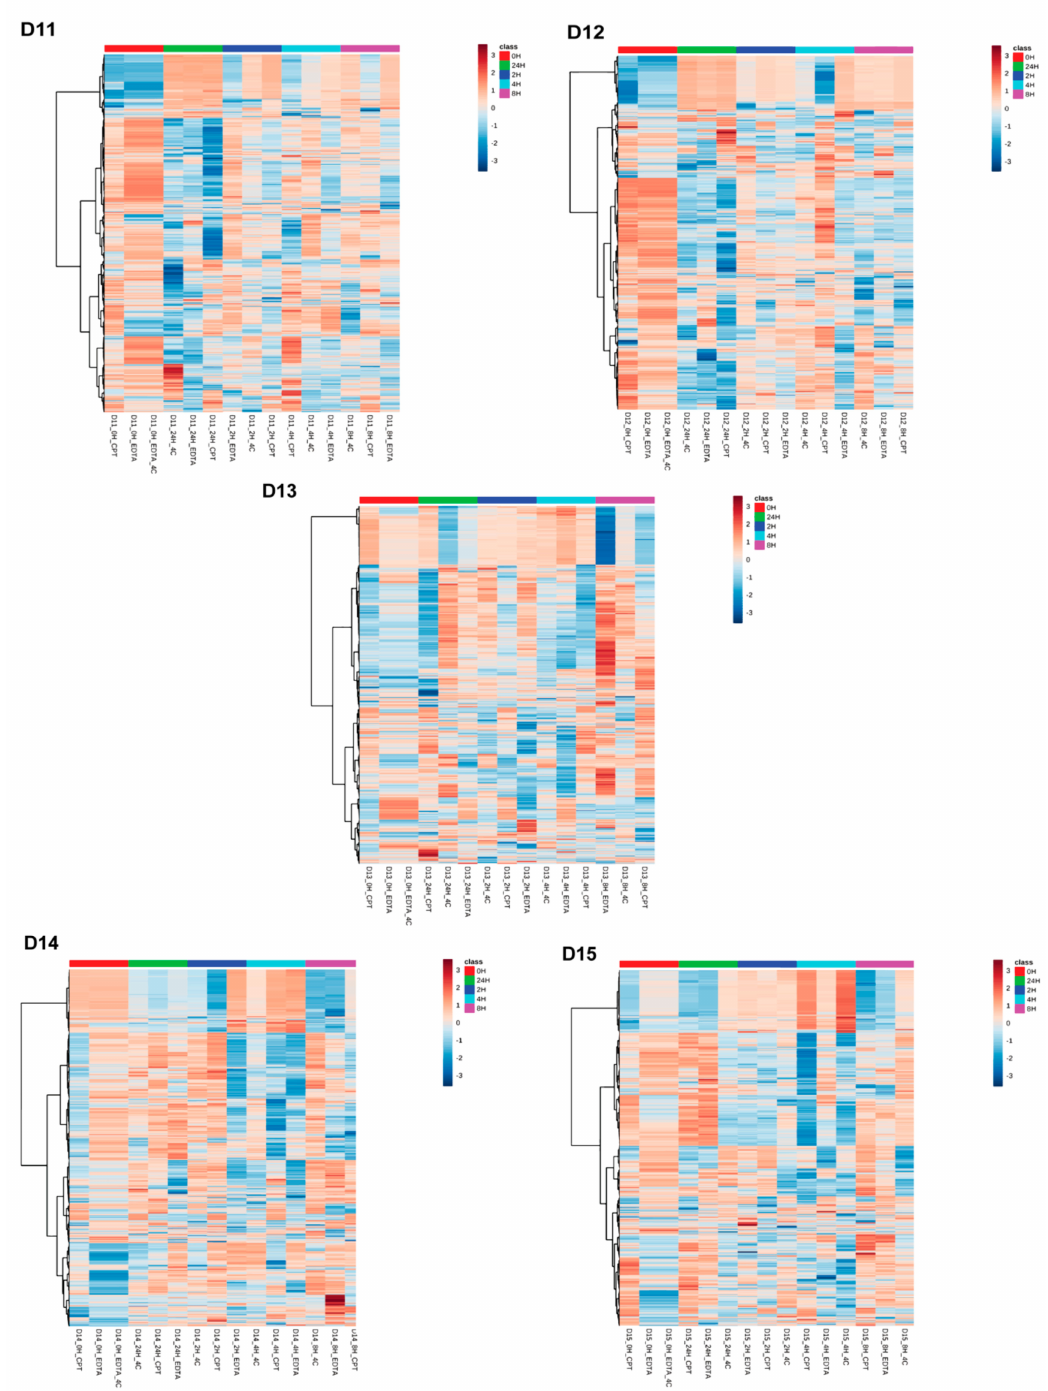
Figure 5. Two-way hierarchical clustering analysis using Euclidean distance and ward.D clustering algorithm among donor-matched samples grouped by storage time. The heatmap shows overall lipid profile di ff erences in negative ionization mode grouped by storage time in donor-matched